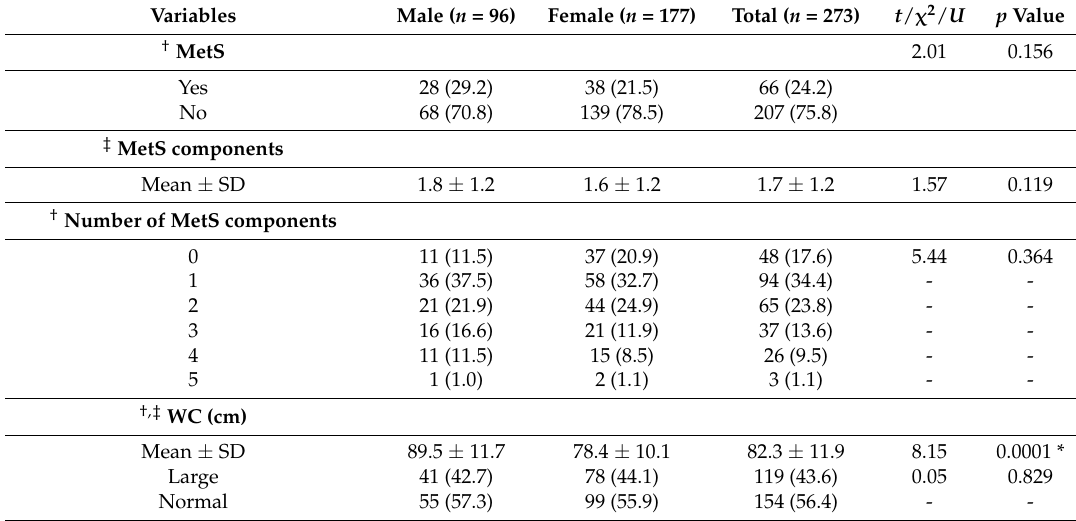
Table 2. Metabolic risks profile of vegetarians by